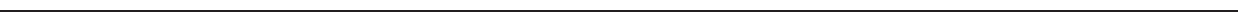
Fig. 8. Myodocope ostracod Rhomboentomozoe rhomboidea (Barrande, 1872), Holy Cross Mountains and Bohemia; Ludlow Series, Silurian. A . ZPAL O.63/16, left valve with incomplete ala, in lateral view. B . ZPAL O.63/17, left valve, in lateral view (B 1 ), detail of the ala (B 2 ), detail of the posterodorsal part of the valve (B 3 ). C . ZPAL O.63/18, left valve with incomplete ala, in lateral (C 1 ), dorsal (C 2 ), and posterior (C 3 ) views, detail of the posterodorsal part of the valve (C 4 ). D . ZPAL O.63/19, left valve with incomplete ala, in lateral (D 1 ), ventral (D 2 ), and anterior (D 3 ) views, detail of the rostrum (D 4 ), detail of the adductorial muscle scar (D 5 ). E . ZPAL O.63/20, left valve with incomplete ala, in lateral view. F . ZPAL O.63/21, right valve, in anterior view showing the ala. G . Holotype, L23322, open carapace in “butterfly” position. H . ZPAL O.63/22, open carapace in “butterfly” position. I . ZPAL O.63/23, right valve, in ventral view showing the proximal part of the ala on the ventrolateral part of the valve (I 1 ), frontal view (I 2 ), detail of the muscle scar (I 3 ) view. All light photographs; A, B 1 , C 1 , C 3 , D 1 , E, F, stereo-pairs. A, E, F, silicone casts of external moulds; B–D, G–I, internal moulds. Scale bars: A, B 1 , C 1 , D 1 , E, G, 1 mm; B 2 , B 3 , C 2 –C 4 , D 2 –D 4 , F, H, I, 500 μ